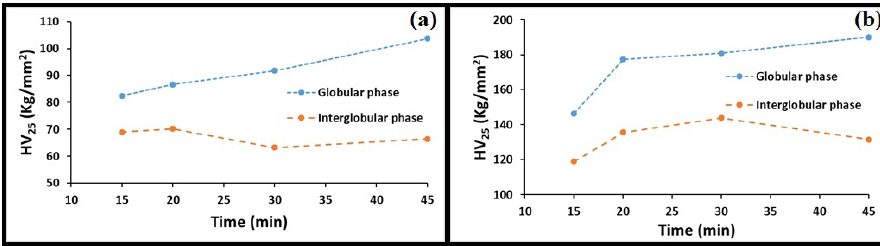
Figure 16. Microhardness of the ZA27 and the ZA27-2%Cu-0.015%Mg alloys, treated at 460°C with the heating